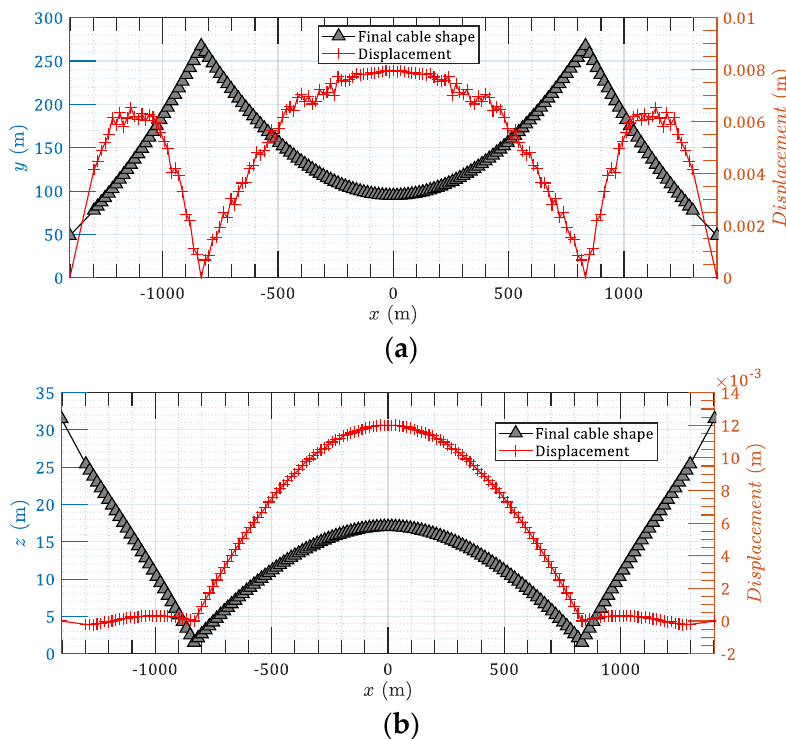
Figure 15. Static displacement of the final 3D spatial main cable achieved by the FEM: ( a ) y -direction;